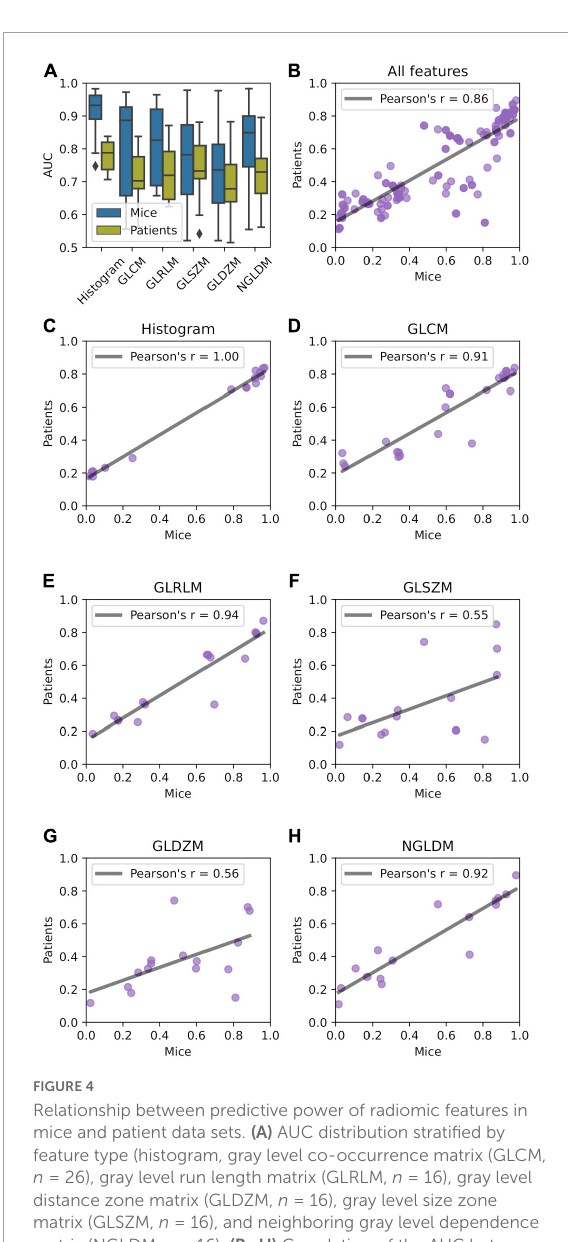
FIGURE4 Relationship between predictive power of radiomic features in mice and patient data sets. (A) AUC distribution stratified by feature type (histogram, gray level co-occurrence matrix (GLCM, n = 26), gray level run length matrix (GLRLM, n = 16), gray level distance zone matrix (GLDZM, n = 16), gray level size zone matrix (GLSZM, n = 16), and neighboring gray level dependence matrix (NGLDM, n = 16). (B–H) Correlation of the AUC between mice and patient